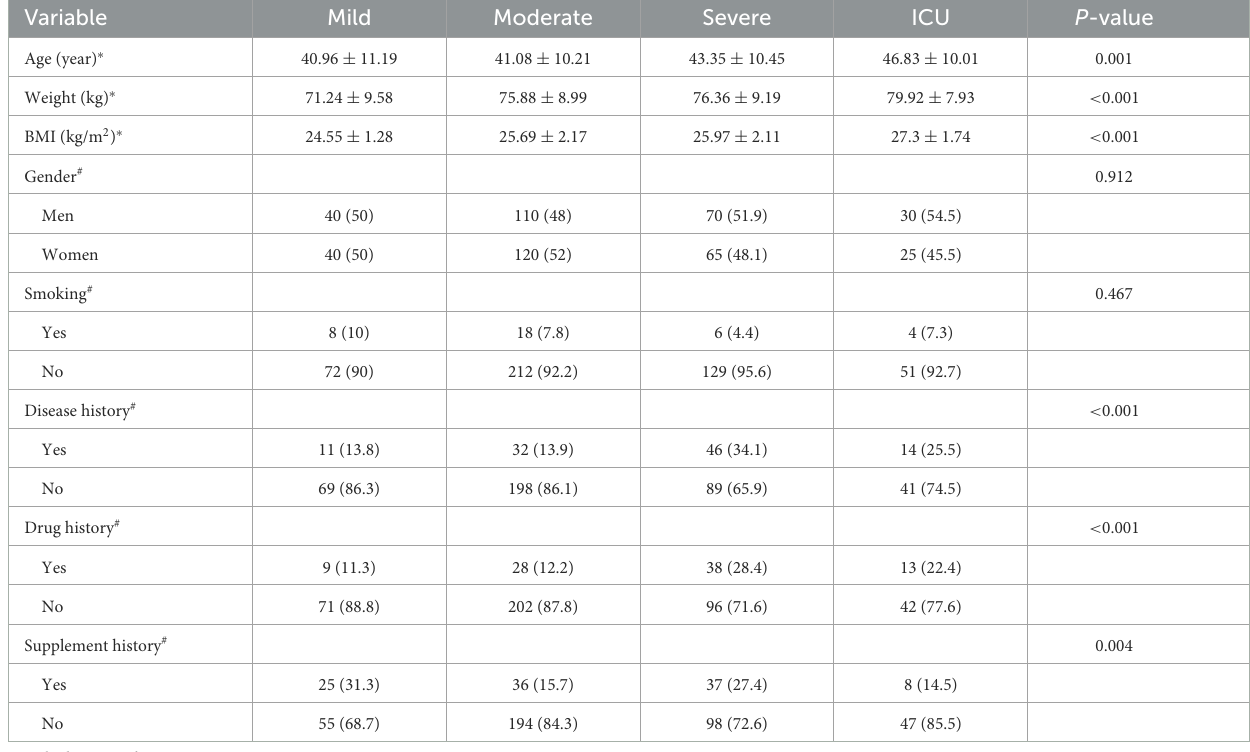
TABLE 1 Comparison of baseline characteristics between different stages of COVID-19 ( N total =